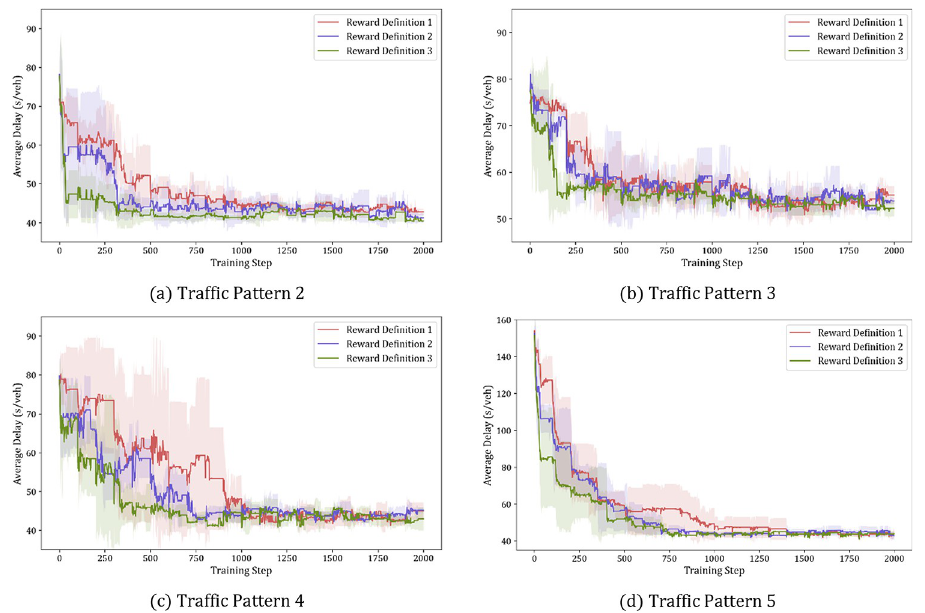
Fig 7. Intersection delay of each traffic pattern for prototype pre-training.